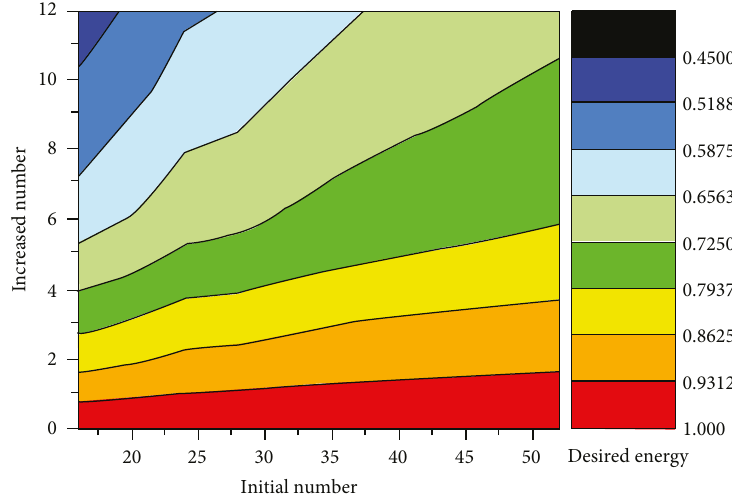
Figure 10: Equipotential map of energy demand.